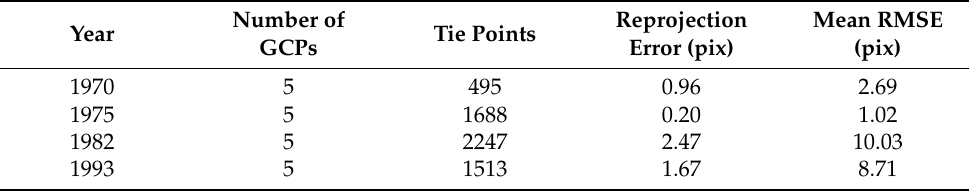
Table 2. SFM block bundle adjustment results.